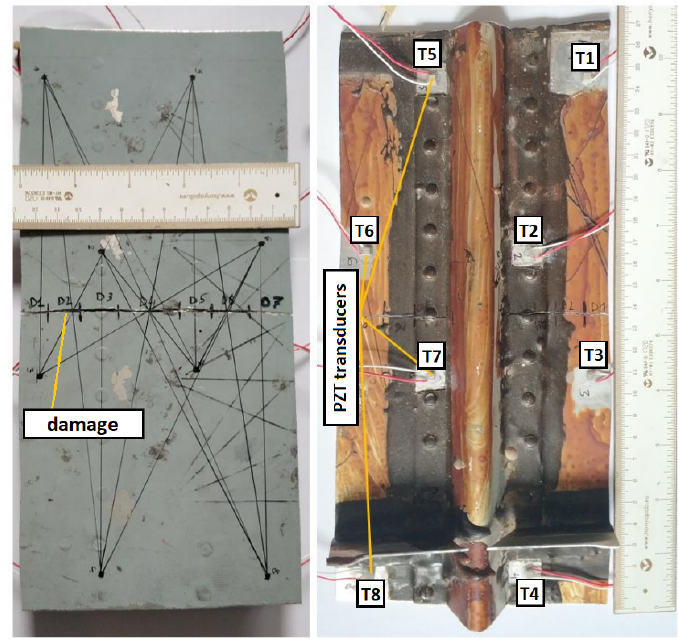
Figure 2. View of specimen no. 1.